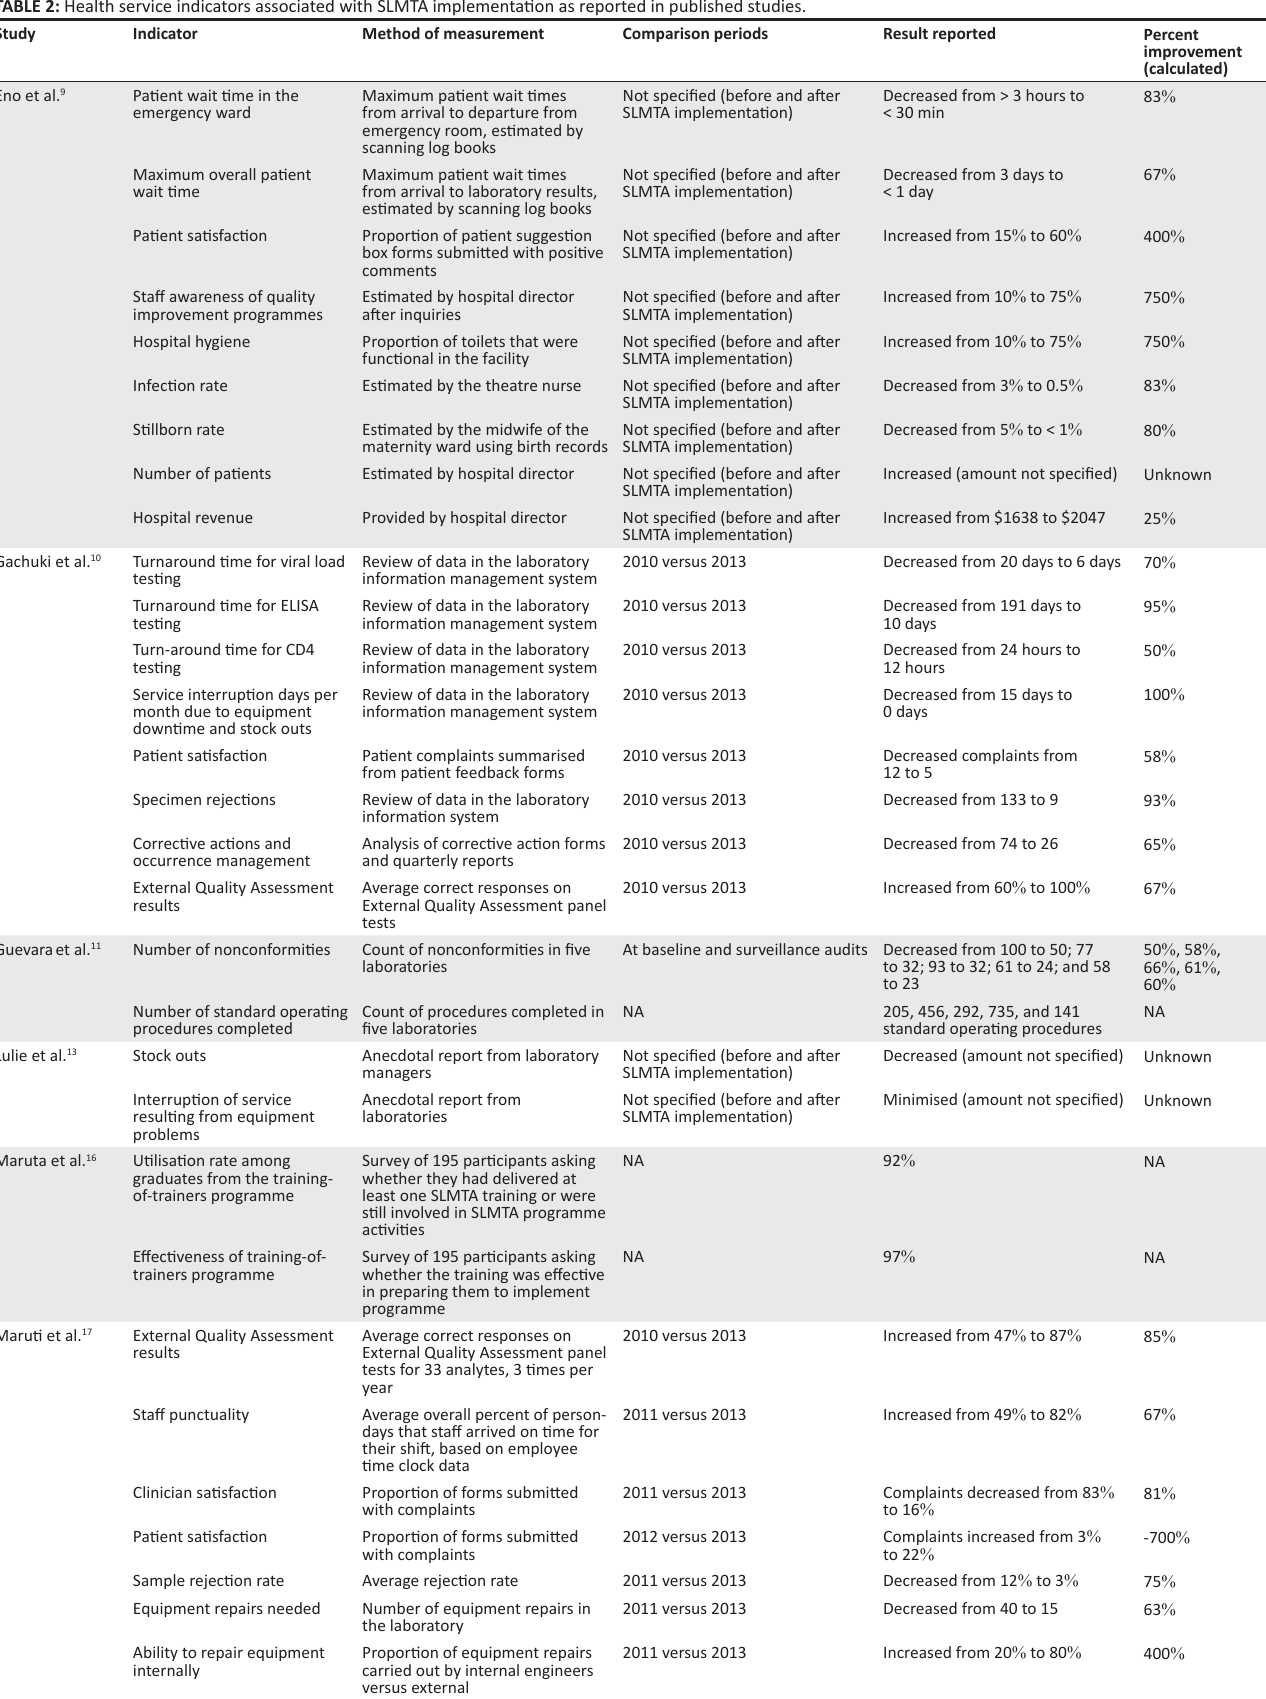
TABLE 2: Health service indicators associated with SLMTA implementation as reported in published studies.